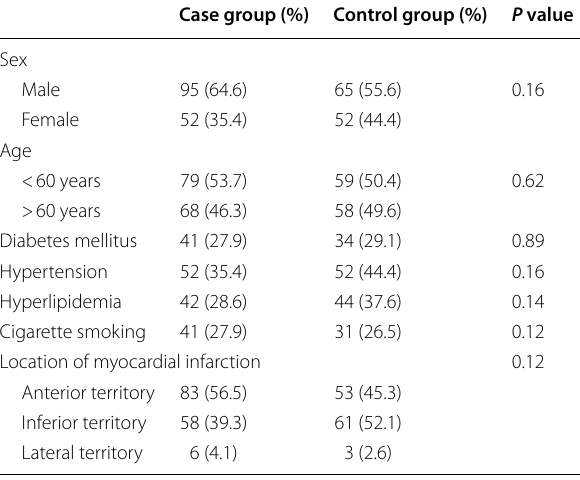
Table 1 Patients’ demographics and clinical